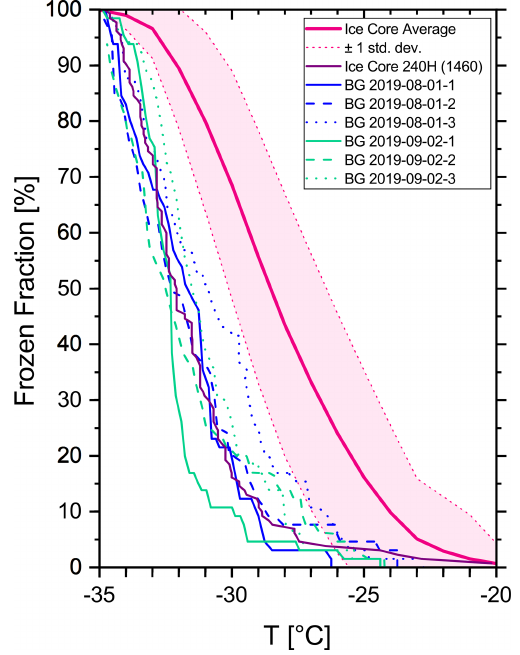
Figure 2. Freezing spectrum of background measurements (blue and green lines) compared to the average freezing spectrum from all ice core samples (pink line) ± 1 standard deviation (pink dotted lines). The purple line shows the least active ice core sample for